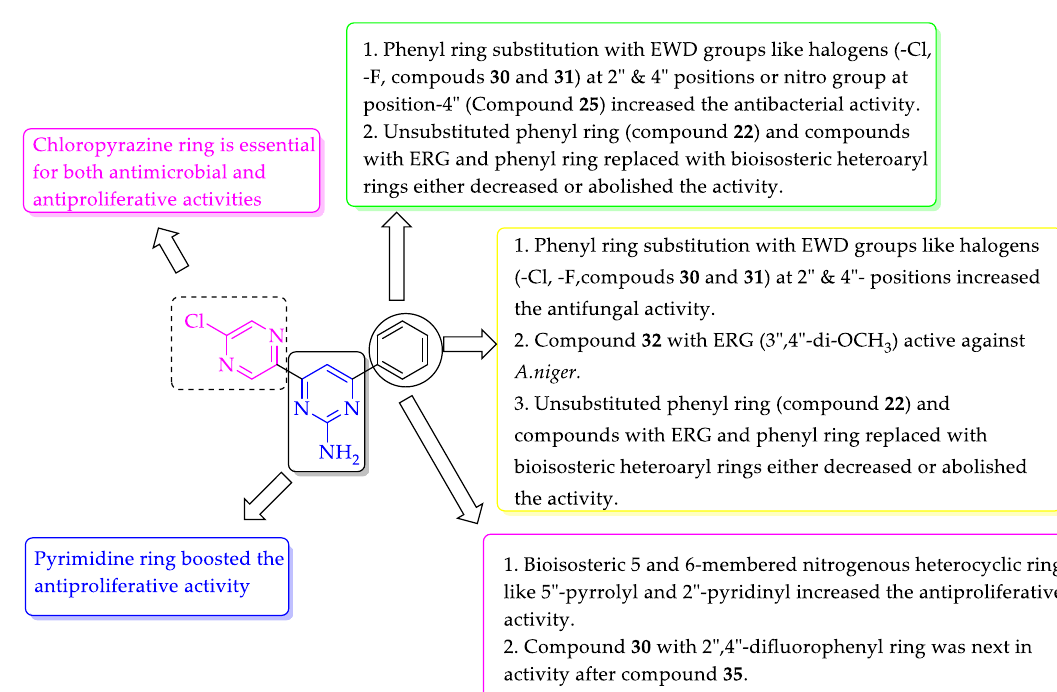
Figure 3. Structure–activity relationship (SAR) features of chloropyrazine-tethered pyrimidine hybrids. EWD = Electron withdrawal; ERG: Electron-releasing group.